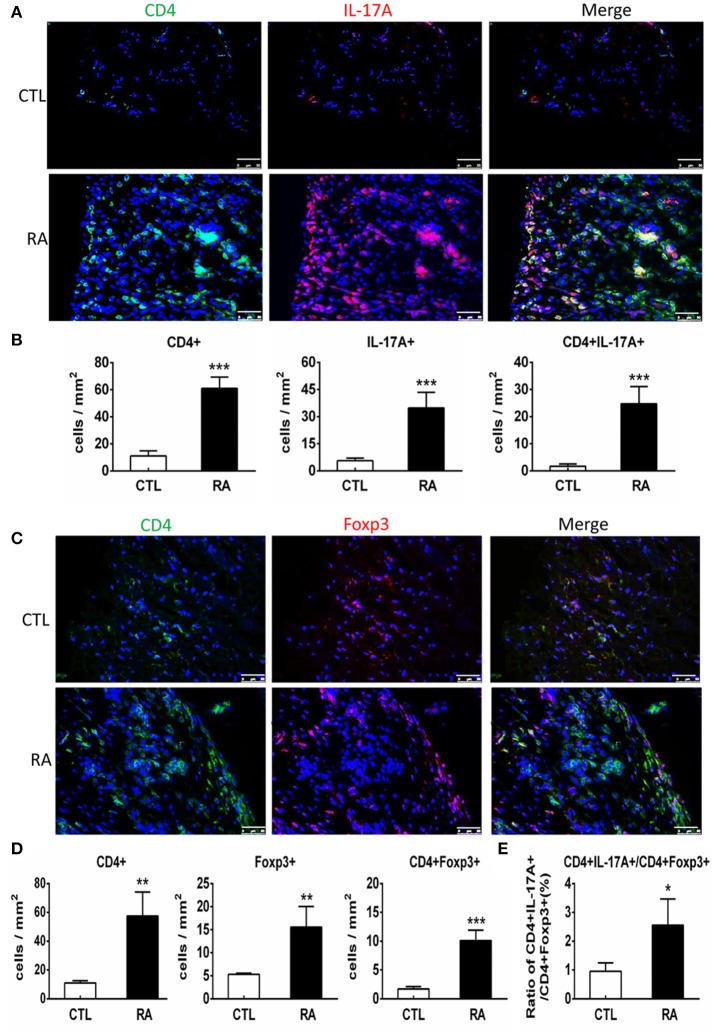
Two-color immunofluorescence detects Th17 and Treg responses in the synovial tissues of RA patients. (A) Expression of CD4+ IL-17A+ cells. (B) Quantitative analysis of CD4+, IL-17A+, and CD4+IL-17A+ cells. (C) Expression of CD4+ Foxp3+ cells. (D) Quantitative analysis of CD4+, Foxp3+, and CD4+ Foxp3+ cells.(E) Ratio of Th17/Treg cells. Note that there is a 2.7-fold increase in the number of CD4+ IL-17A+ cells compared to CD4+ Foxp3+ cells in patients with RA. Data represent mean ± S.E. for 14 RA patients. *p < 0.05, **p < 0.01, ***p < 0.001 compared to normal controls. Scale bar, 50 μm.